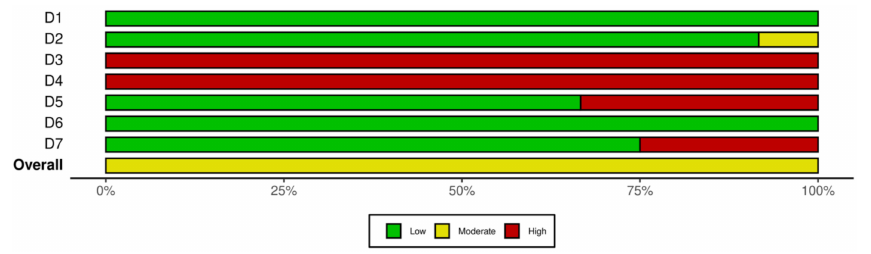
Figure 3. Summary of risk of